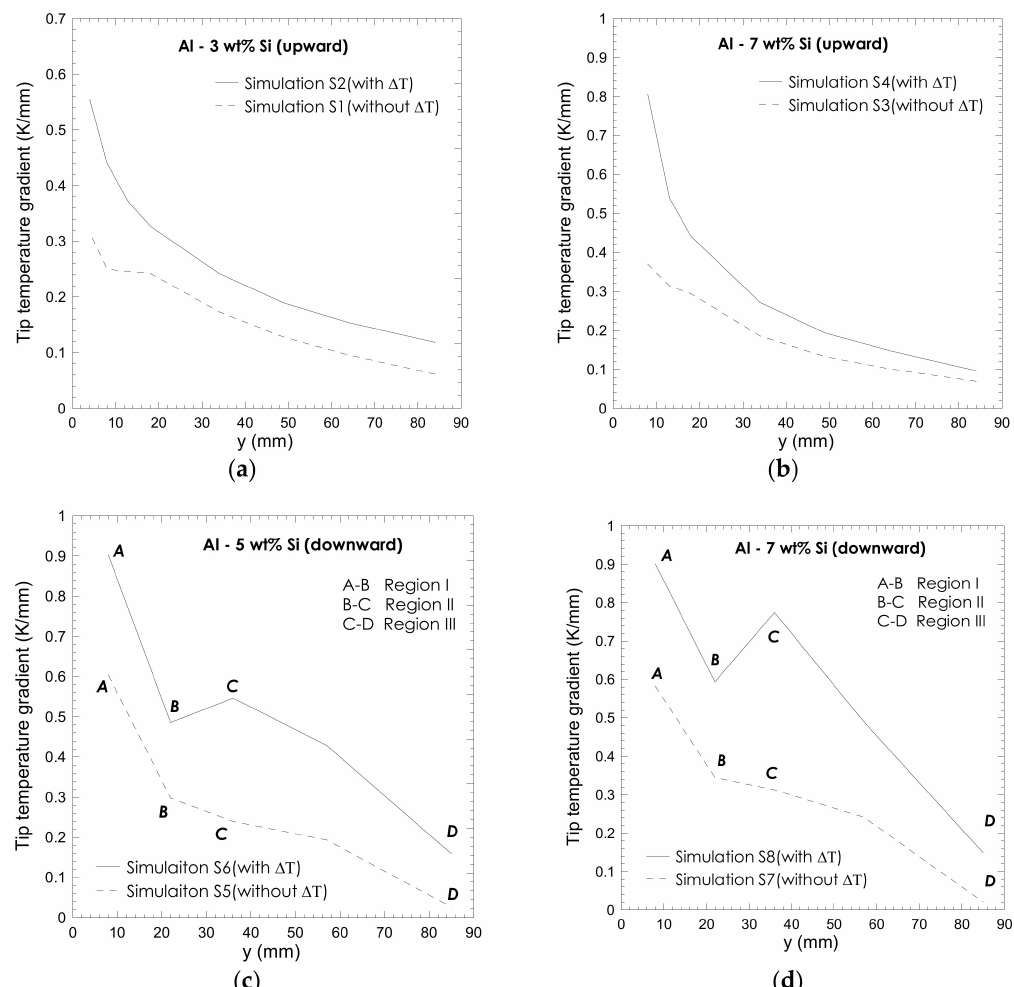
Figure 18. Effect of the undercooling on tip temperature gradient during solidification. ( a ) 3% upward; ( b ) 7% upward; ( c ) 5% downward; ( d ) 7%